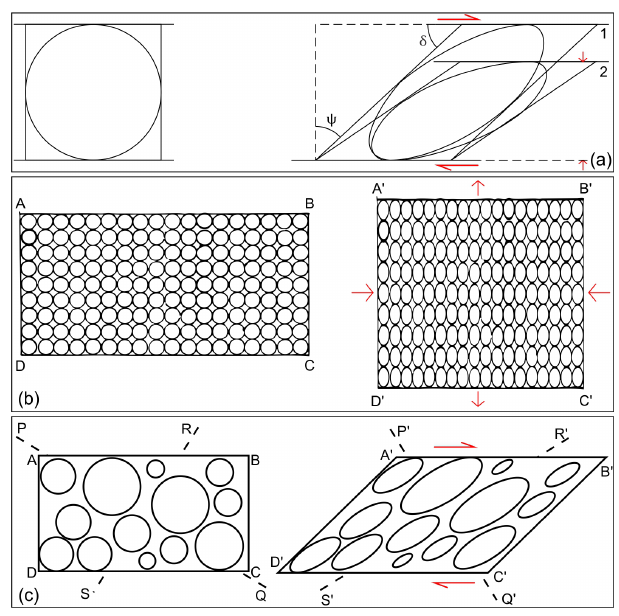
Figure 4. (a) Simple shear deformation according to Fisher (1884a, his Fig. 1). Deformed shape 1 corresponds to simple shear and 2 to simple shear plus contraction normal to the shear plane. Dashed lines and red arrows are added to the original figure to illustrate the shear angle ψ and its complementary δ . (b–c) Redrawn Figs. 1 to 3 of Van Hise (1896), showing pure shear (b) and simple shear (c) de- formation of circular objects in a layer ( ABCD ). Cleavage will be parallel to lines B (cid:48) C (cid:48) or R (cid:48) S (cid:48) , respectively. Red arrows are additions to the original